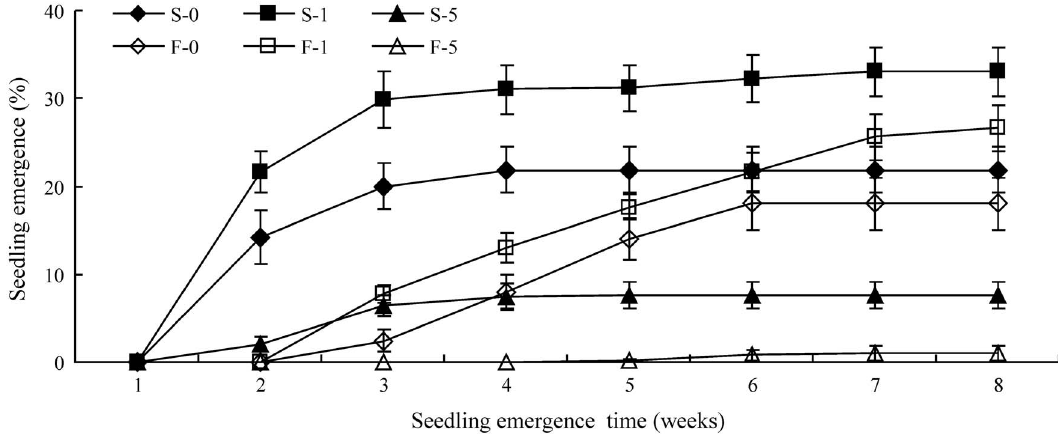
Figure 5. Seedling emergence from fresh (F) and one-year-stored (S) seeds of Stipabungeana at 0, 1 and 5 cm sowing depths. F-0, F-1 and F-5 indicate fresh seeds sown at a depths of 0, 1 and 5 cm, respectively (n=10). S-0, S-1 and S-5 indicate seeds stored for one year and then sown at depths of 0, 1 and 5 cm, respectively (n=10).